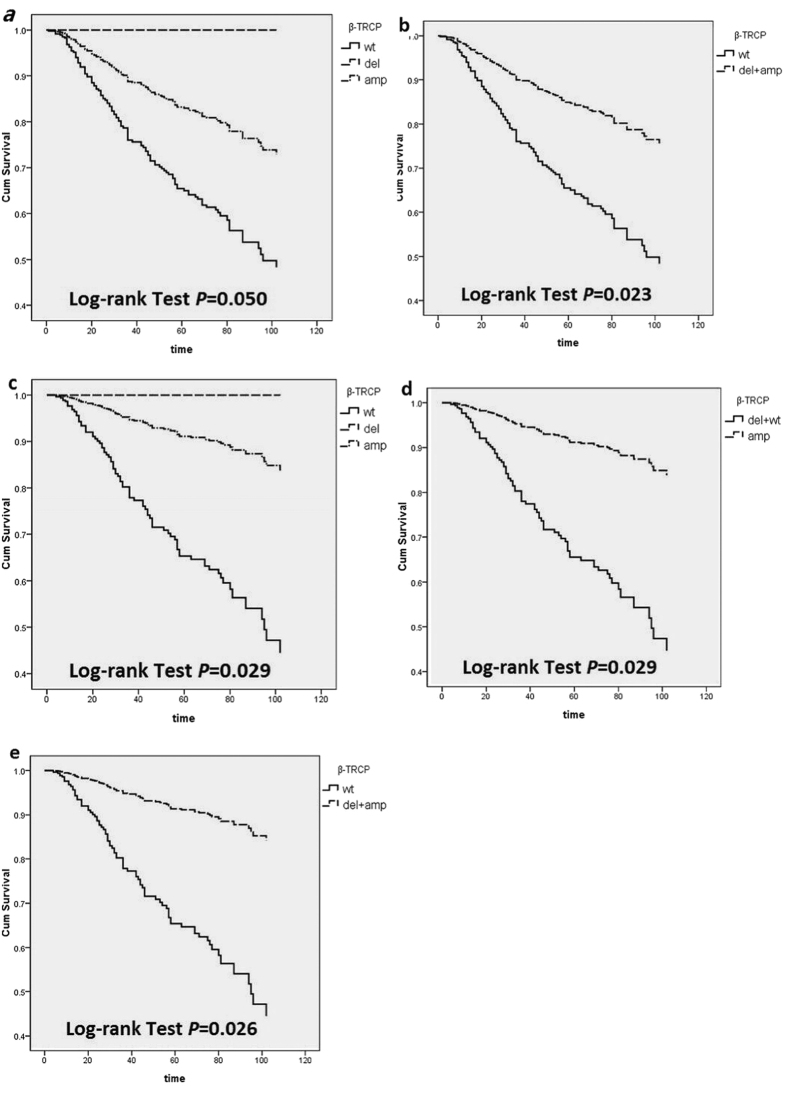
Kaplan–Meier curves of overall survival (OS) according to the five genes CNVs in patients with rectal cancer.(a) β-TRCP CNVs in CRC; (b) β-TRCP CNVs in combined model in CRC; (c) β-TRCP CNVs in rectal cancer; (d) β-TRCP amplification in rectal cancer; (e) β-TRCP CNVs in combined model in rectal cancer.